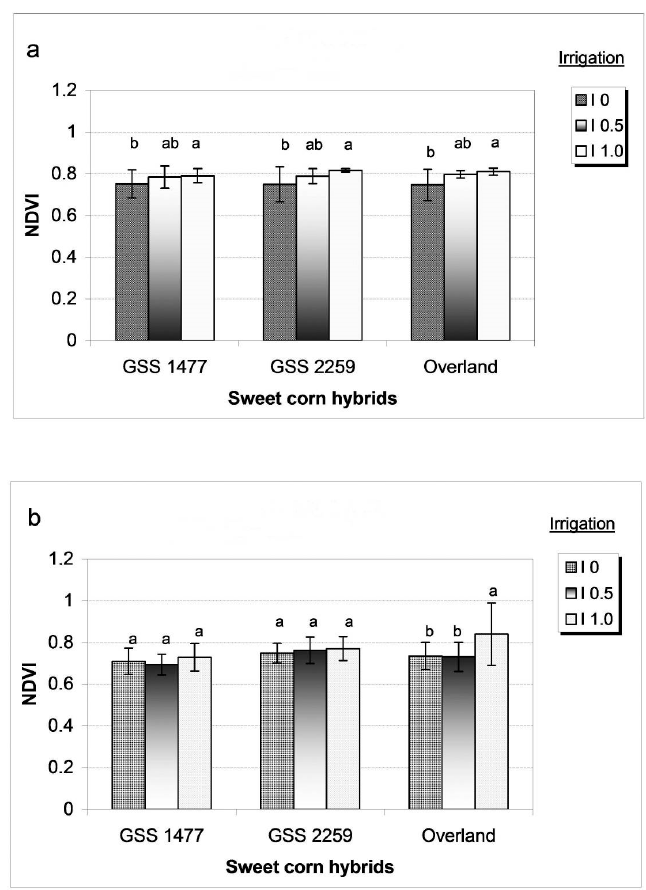
Figure 4. Effect of water supply on NDVI at canopy level ( a ) during tasseling and ( b ) during silking of sweet corn. The data presented the average of years ± SD. Mean values followed by the different letters are significantly different at the p < 0.05 level. I 1.0 = regularly irrigated I 0.5 = moderate water deficit I 0 = unirrigated, severe dry conditions.